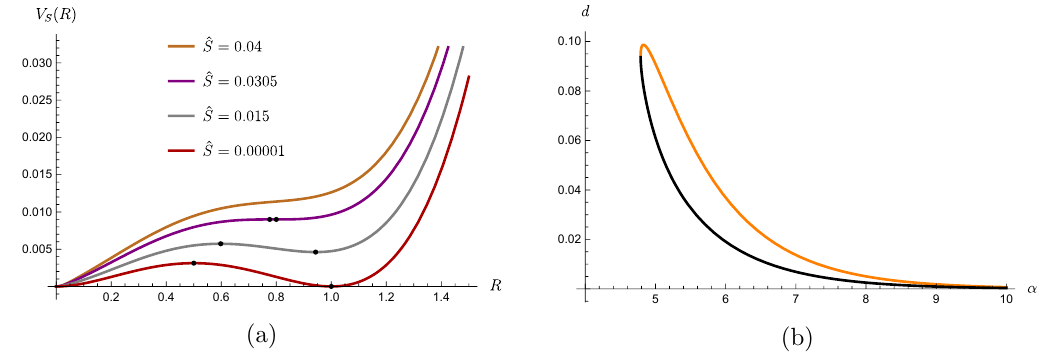
Figure 1. a) Effective potential for a choice of parameters such that c = 10 , where for illustrative reasons we pick m so that the non-zero extremal minimum is located at one in L = 1 units. The black dots represent the non-trivial extrema. The purple curve captures the potential felt by the brane for a value of the entropy close to the critical one. b) Plot of the ratio d comparing the scale associated to the Schwarzschild radius with the radius R set by the equations of motion of the brane, as a function of the non-extremality parameter α , for the choice c = 30 and keeping the same convention for the mass perturbation as in